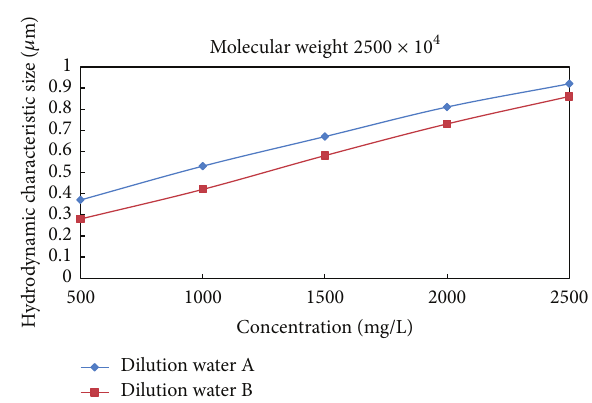
Figure 5: The hydrodynamic characteristic size increased obviously with the increase of concentration of polymer solution.